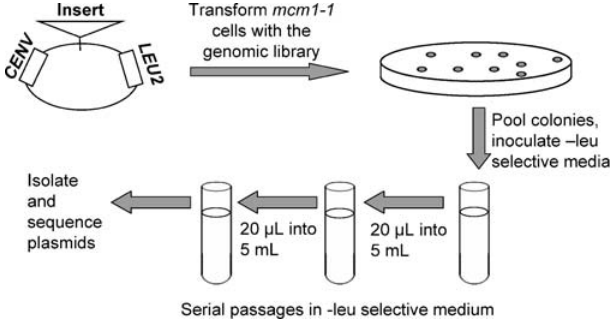
Figure 1. Serial Passages of a Plasmid Library of Genomic DNA in mcm1– 1 Cells to Enrich for Stable Plasmids Containing A-Type ARSs DOI: